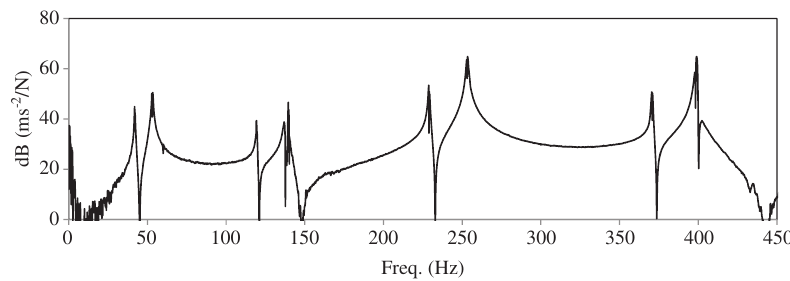
Figure 10: Magnitude of FRF corresponding to H